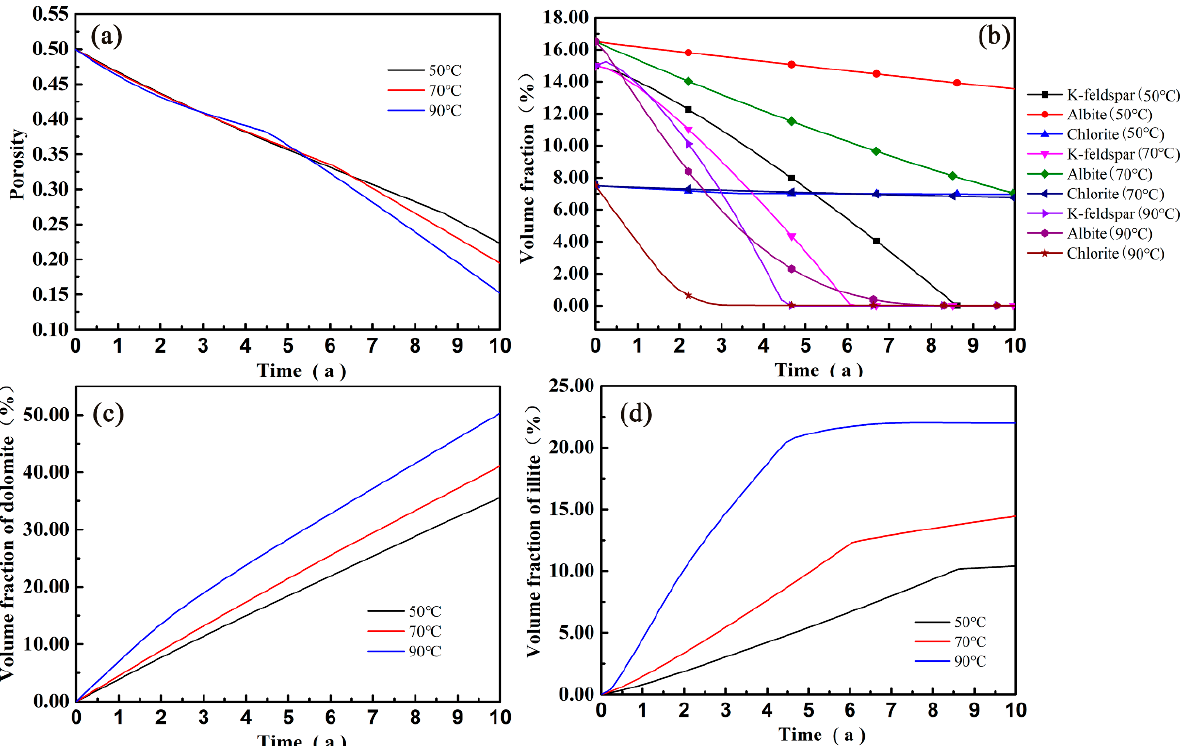
Figure 10. Simulation results at different injection temperatures. ( a )—Porosity; ( b )—Permeability; ( c )—Dolomite; ( d )—Illite.